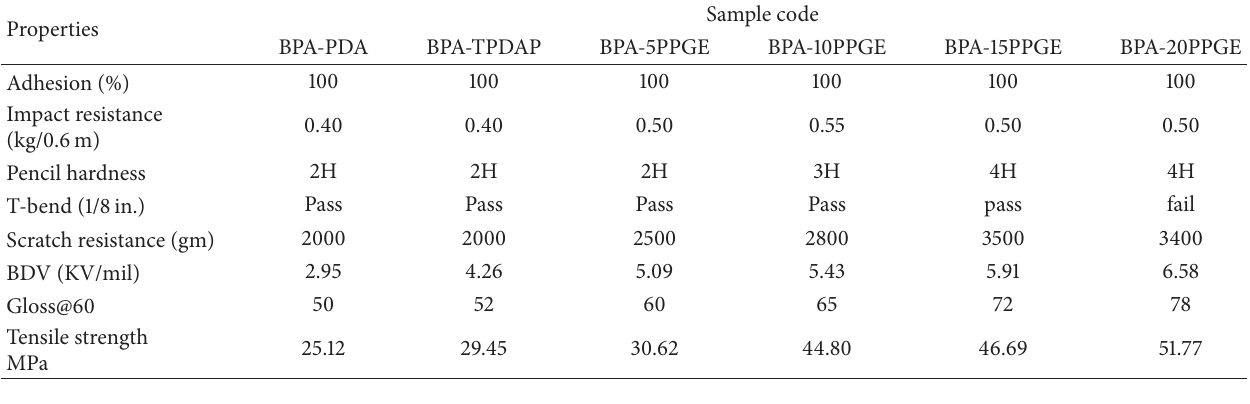
Table 2: Mechanical properties of epoxy resin-PPGE coatings.